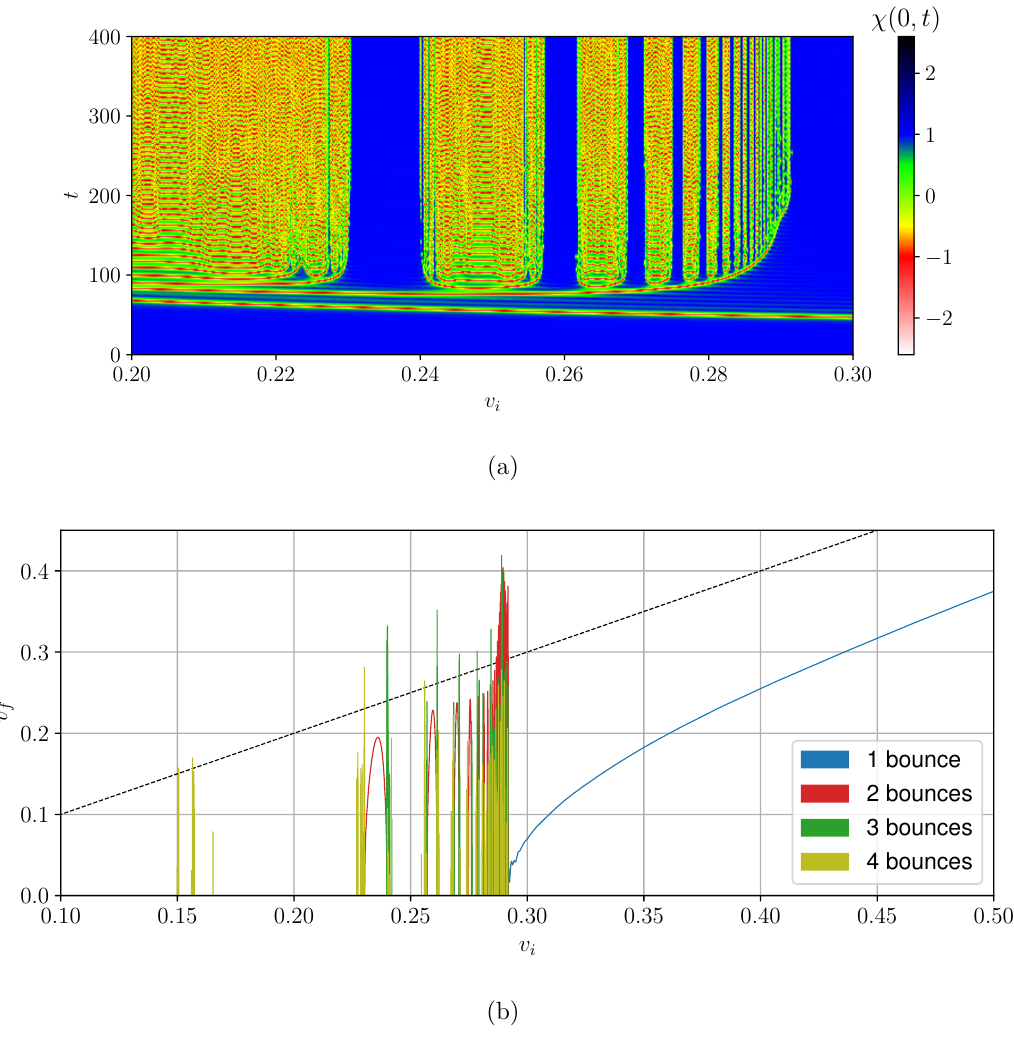
Figure 7 . (a) Field at the collision center as a function of time and initial velocity. (b) Kink’s final velocity as a function of the initial one. Dashed line corresponds to the identity curve. We fix φ 0 = 0 . 8